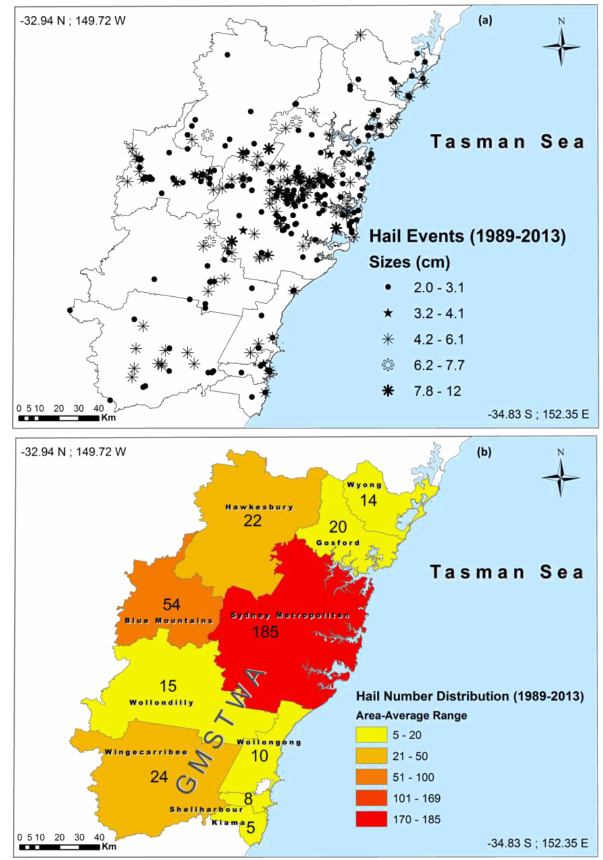
Figure 10. Spatial distribution of (a) individual hail events and (b) area-averaged hail events. The total number of hail events is also given inside of each LGA